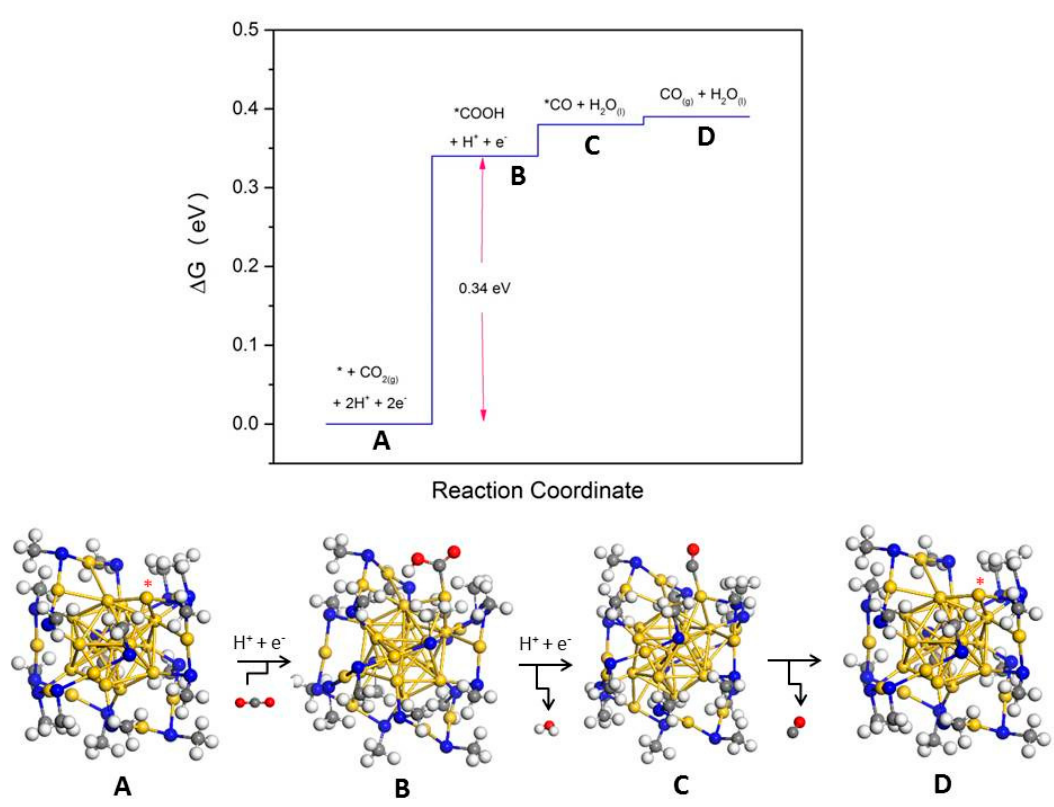
Figure 2. Free energy diagram for electrochemical reduction of CO 2 to CO on the dethiolated cluster at T = 298 K, pH = 0 and zero applied potential. White, gray, blue, gold and red balls represent H, C, S, Au atom and O atoms, respectively. Reprinted from Ref. [28] with the permission of AIP Publishing. Copyright (2016) AIP Publishing.